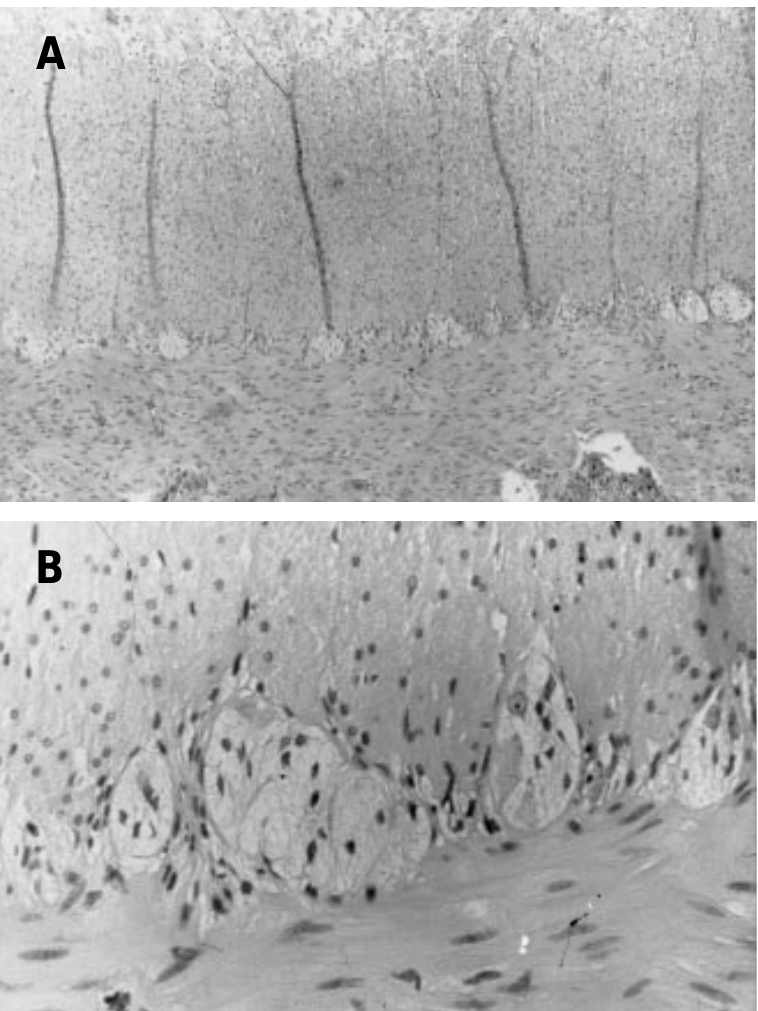
Figure 9 - Morphology of the intestinal motor apparatus in the transplanted intestine. A, Low-power magnification (hematoxylin and eosin stain) view of a cross-section through the small intestinal wall obtained at the time of restoration of intestinal continuity, six months following successful small intestinal transplantation. Note intact, normal-appearing, muscle layers (circular above, longitudinal below). B, High-power view of the myenteric plexus from the same specimen. Neuronal cell bodies in the myenteric plexus appear dilated and